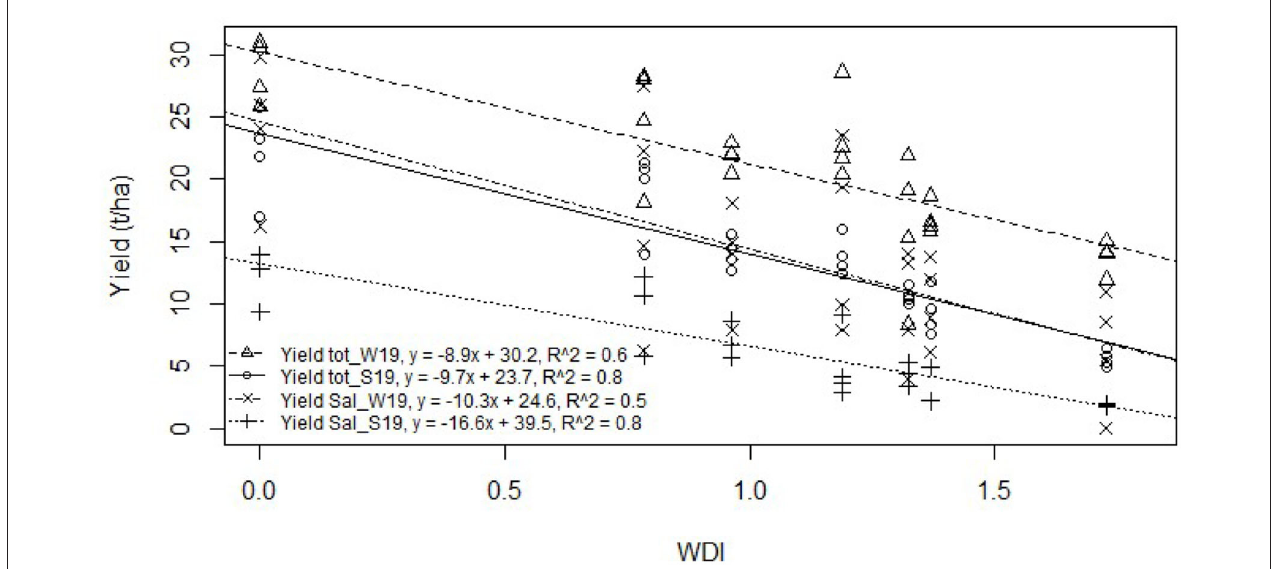
FIGURE 8 | Relation between the two yield components and the water deficit index (WDI) for